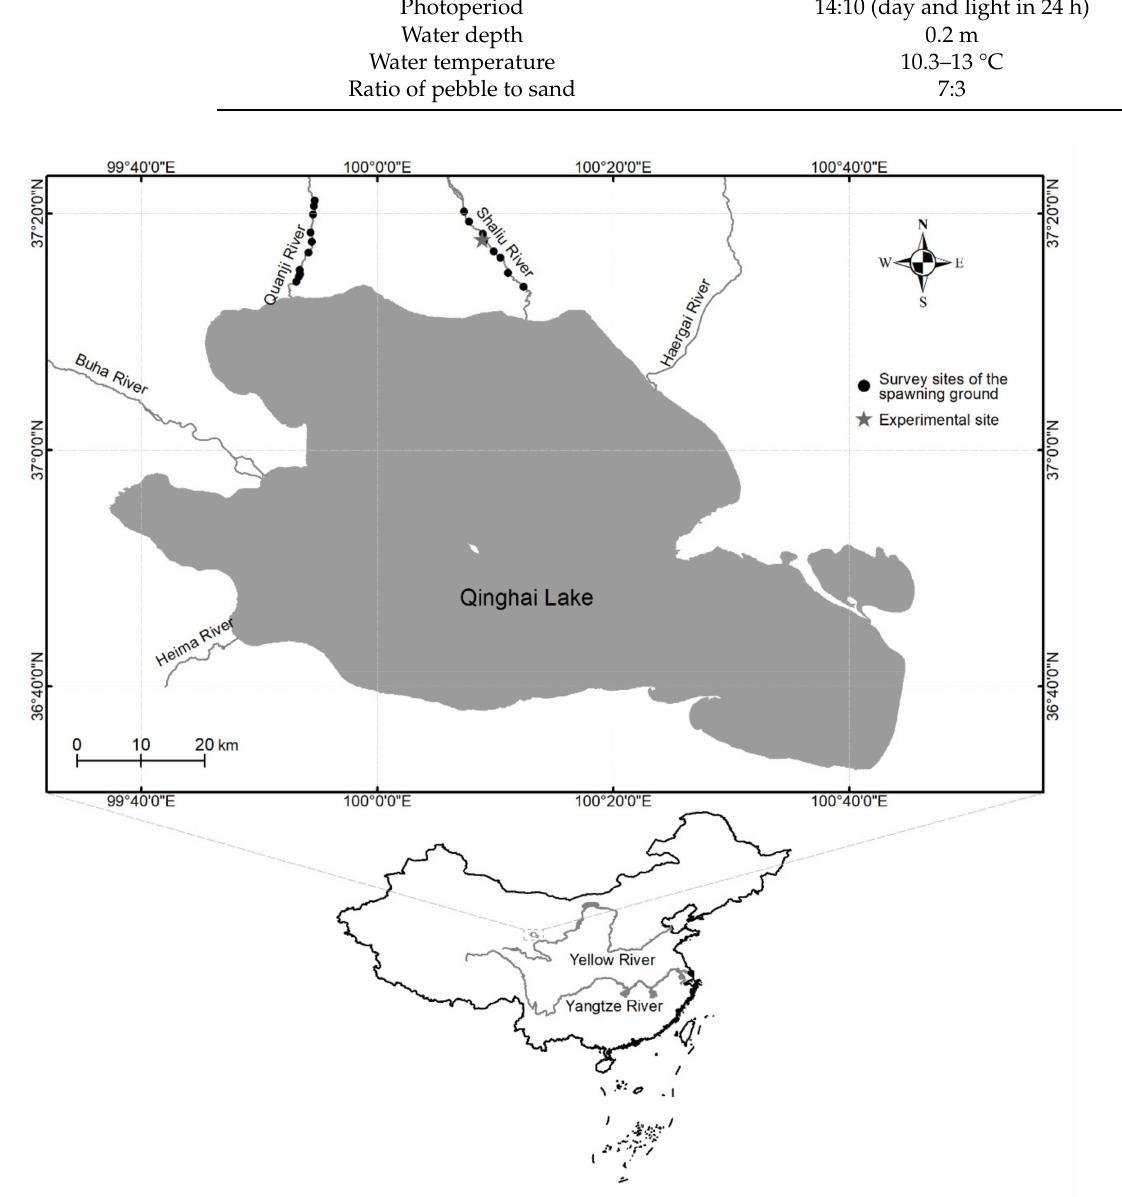
Figure 1. In situ observations and measurements sites of the spawning grounds in Shaliu and Quanji